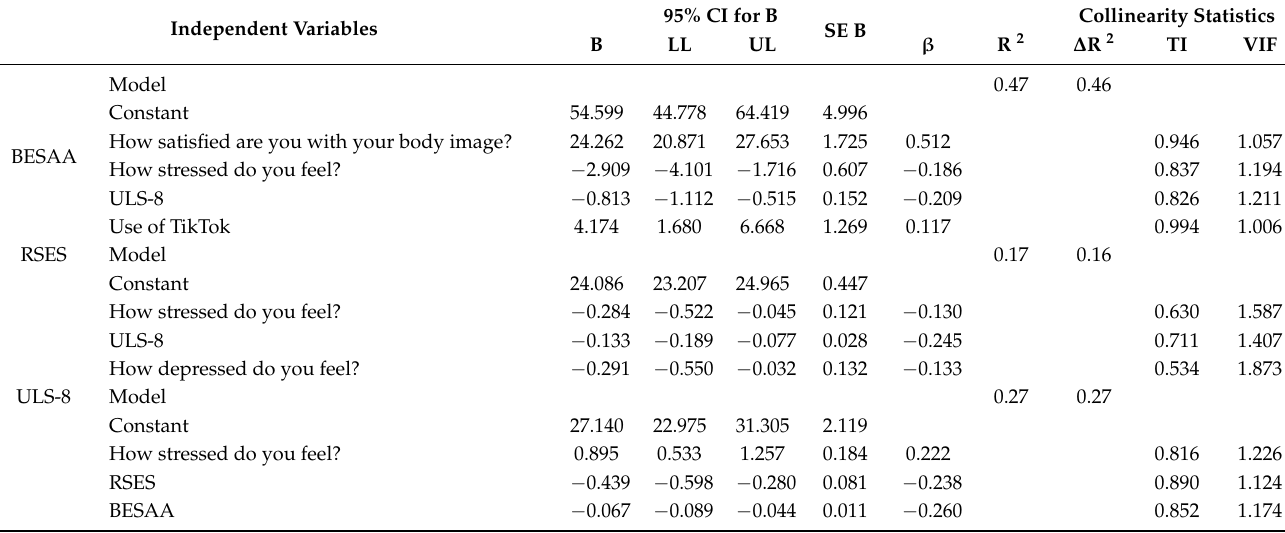
Table 6. Regression coefficients and standard